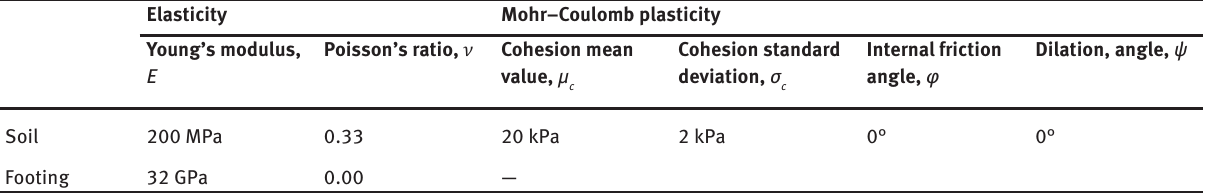
Table 1: Assumed model